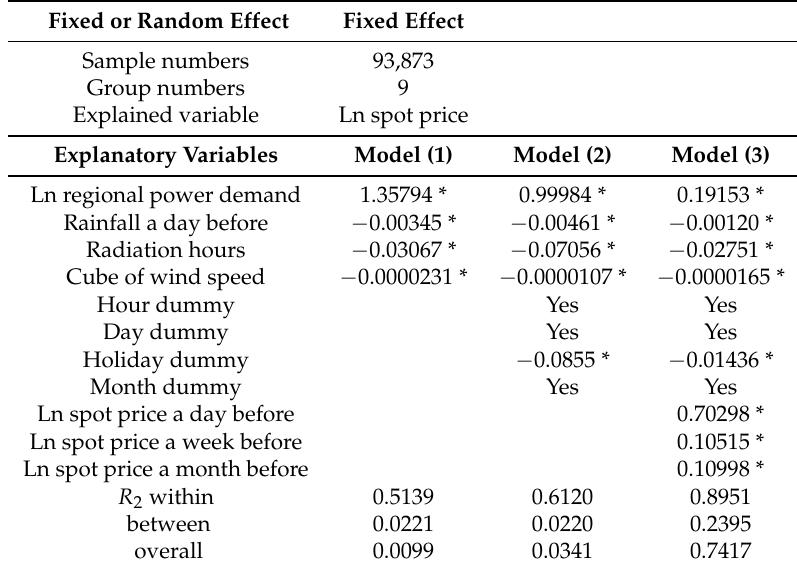
Table 3. Result of the empirical